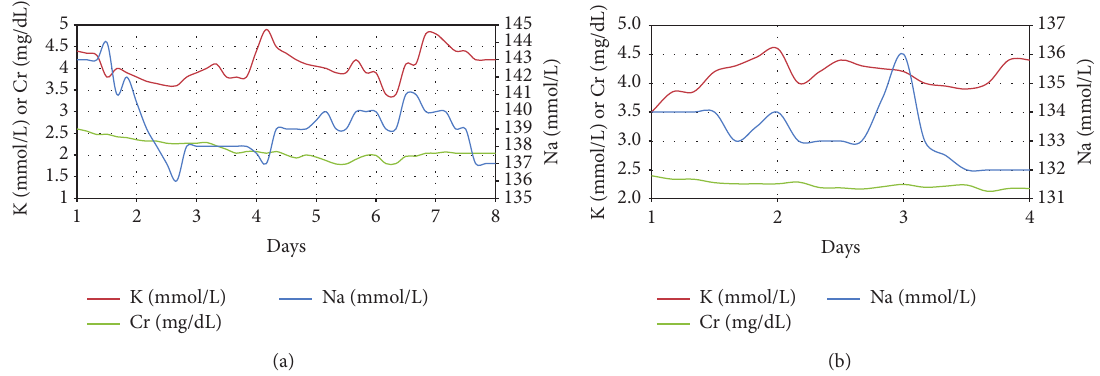
Figure 1: Change in serum potassium, sodium, and creatinine during treatment with quadruple therapy in Case 1 (a) and Case 2 (b).